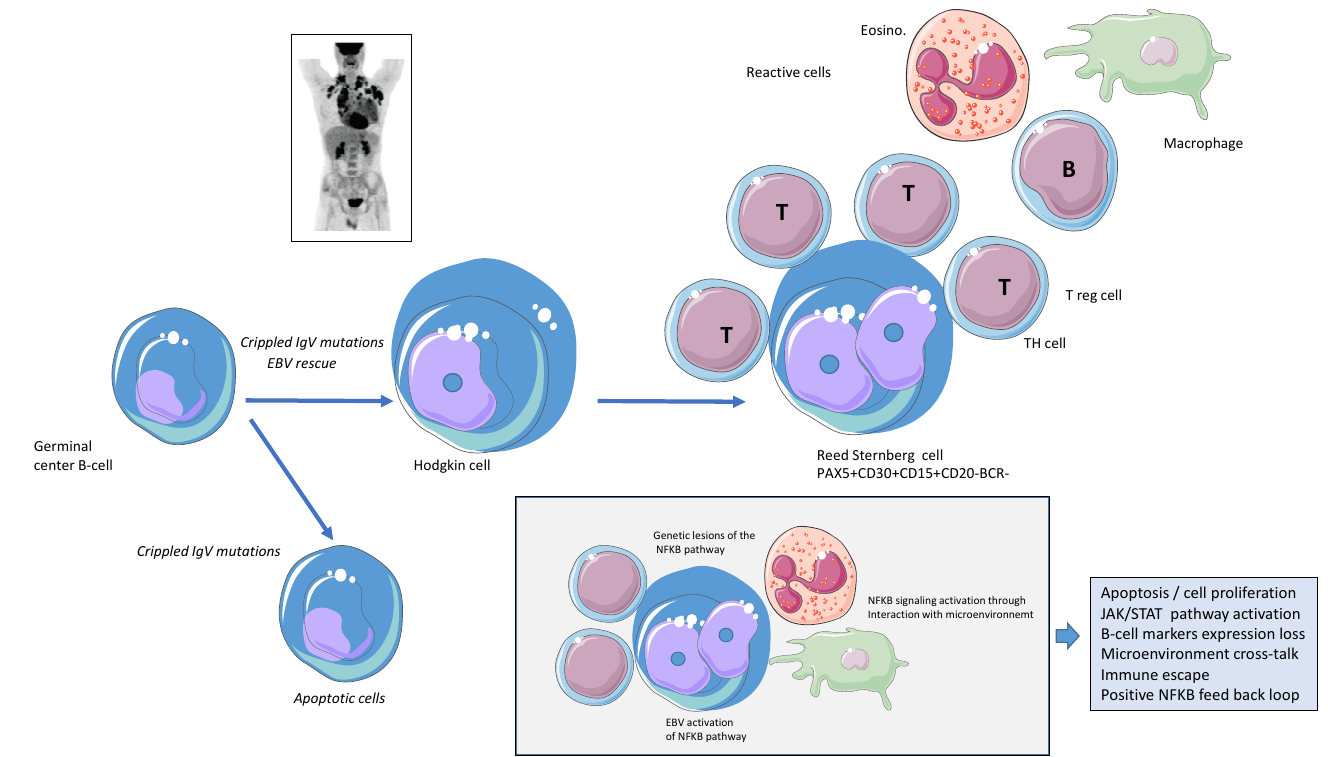
Figure 1. Schematic physiopathological model of classical Hodgkin lymphoma and its relationship with the NFkB pathway. The tumor cells that drive classical Hodgkin lymphoma (cHL) are Hodgkin and Reed-Sternberg (HRS) cells. These B cells are isolated from the germinal center and are rescued from apoptosis despite unproductive or crippled IgV by mechanisms that involve Epstein Barr virus (EBV) or NFkB deregulation. Interaction with the microenvironment, including mainly T cells but also mastocytes, macrophages, and myeloid cells, creates an interaction that favors HRS cell survival. The NFkB pathway is deregulated by multiple mechanisms, including NFkB signaling activation through genetic lesions, interaction with microenvironment cells, and TNF receptor activation or EBV activation. The deregulation of the NFkB pathway is involved in the transcriptional control of several target genes involved in apoptosis, the JAK/STAT pathway, B-cell marker expression loss, microenvironment crosstalk, or cell proliferation. Figure generated using Servier Medical Art and personal archive PET scan imaging.